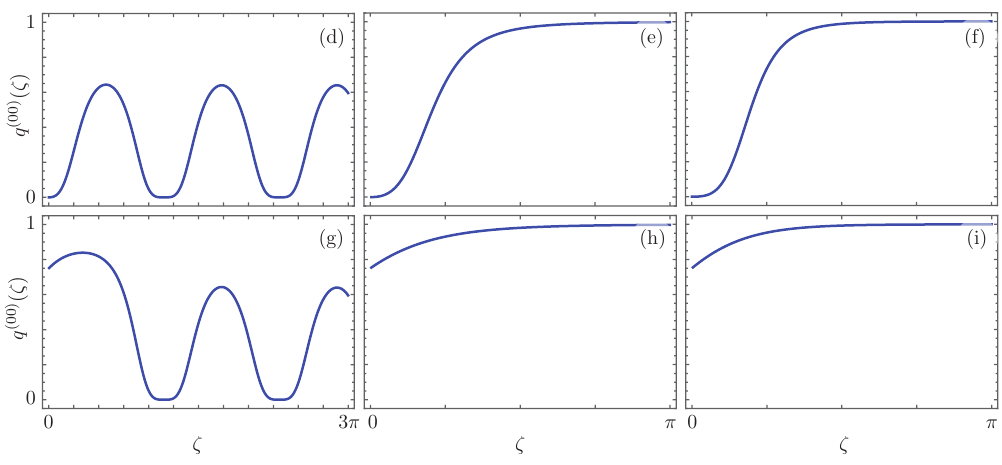
Figure 3. Photon bunching shown in terms of the q ( 00 ) ( ζ ) parameter for different realizations of the effective -symmetric dimer. The first row, ( a – c ), shows balanced gain-loss, second row, ( d – f ), shows PT gain-gain, and third row, ( g – i ), shows gain-passive configurations in the -symmetric regime, the PT = 0.5, the Kato point with = 1, the second column, and broken symmetry γ γ first column with | | | | = γ regime, and the third column with | |